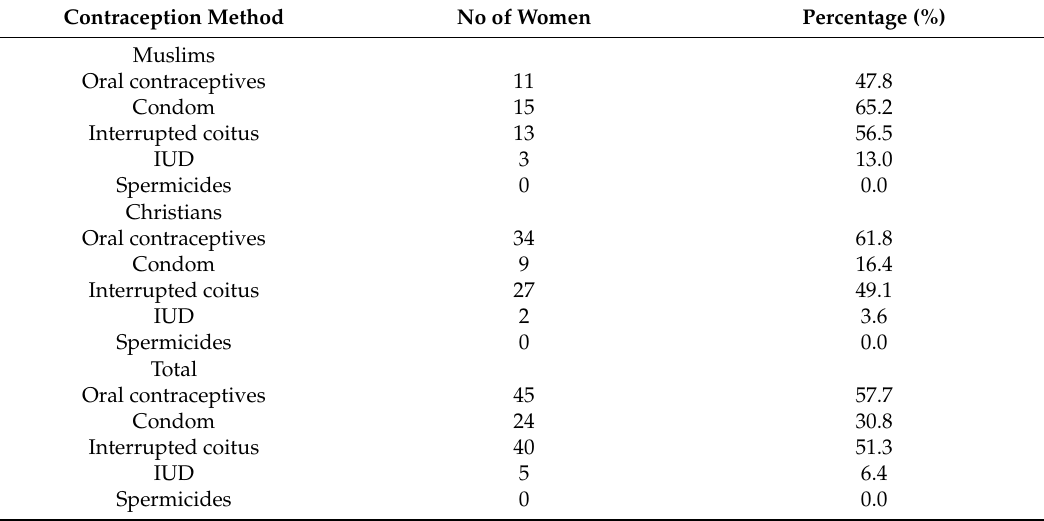
Table 6. Method of contraception in the participants with ance, hirsutismus and late age of menarche in relation to